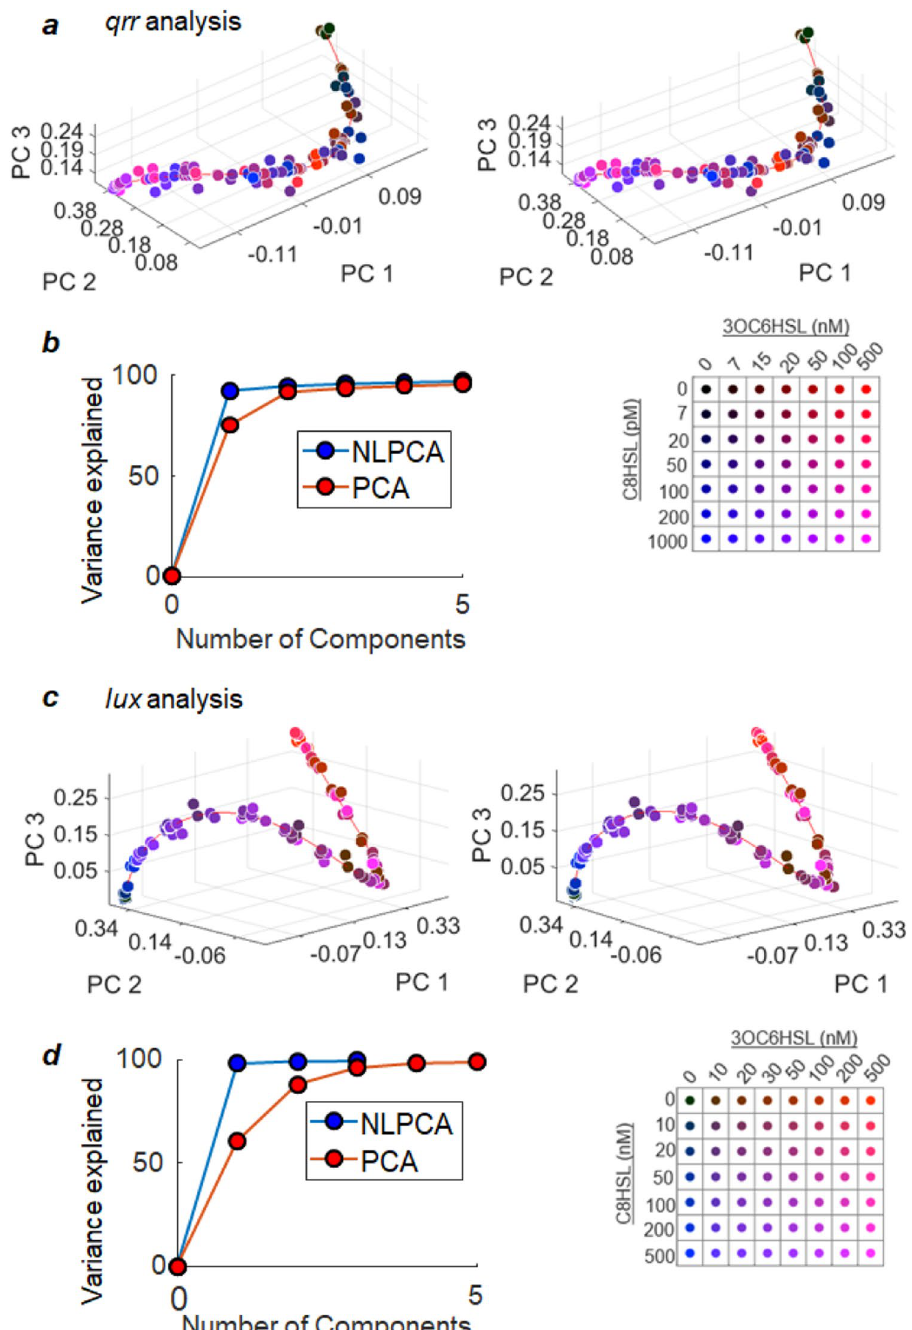
Figure 6. Low dimensional representation of the qrr and lux histograms. The set of PCA scores associated with each HSL concentration condition (Figs. 4a and 5a) defines a point in the multidimensional coordinate space of the principal components PC1, PC2, etc. The stereogram in (a) represents all such points for the qrr data in the three dimensional space of PC1-PC3. HSL conditions for each point are color-encoded using the key shown beneath (a) . The NLPCA analysis (“Methods”) further identifies a nonlinear coordinate, corresponding to the solid red curve in (a) , which threads the qrr data. As shown in (b) , this NLPCA coordinate is able to capture 92.2% of the variance in the full dataset. The stereogram in (c) similarly represents the points for lux in the three dimensional space of PC1-PC3. The solid red curve represents a single, one-dimensional nonlinear coordinate obtained by NLPCA. This coordinate threads the lux data and (d) captures 97.1% of the variance in the